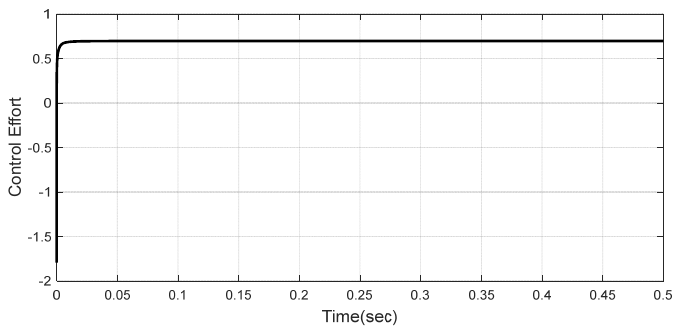
Figure 25. Controller effort signal in the presence of measurement noise.